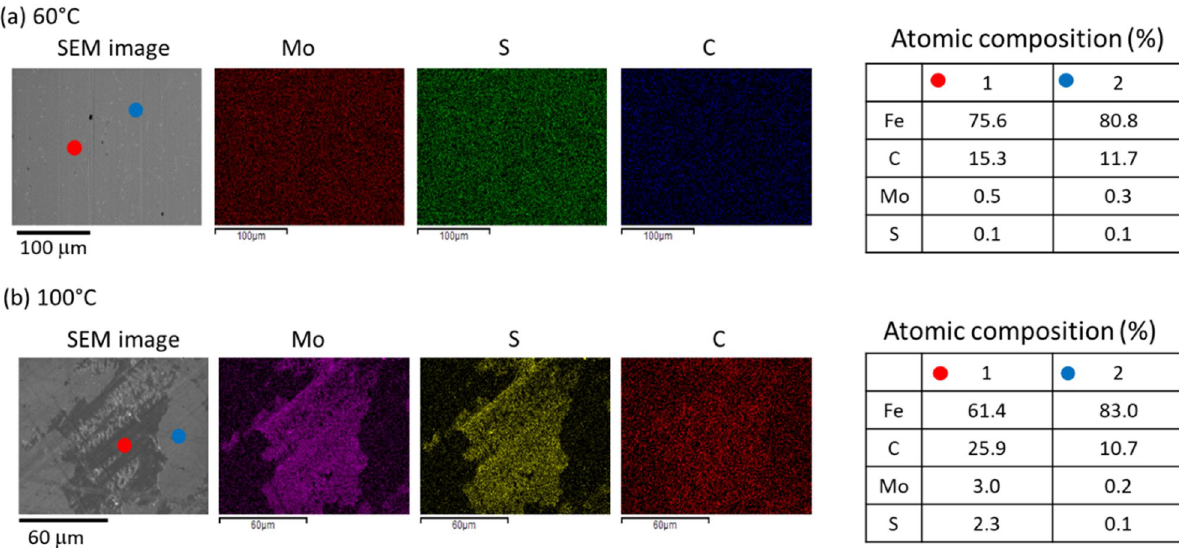
Figure 4. SEM image and EDX scan of contact tracks without wiping showing relative chemical abundance of molybdenum, sulphur and carbon after a test at ( a ) 60 °C and ( b ) 110